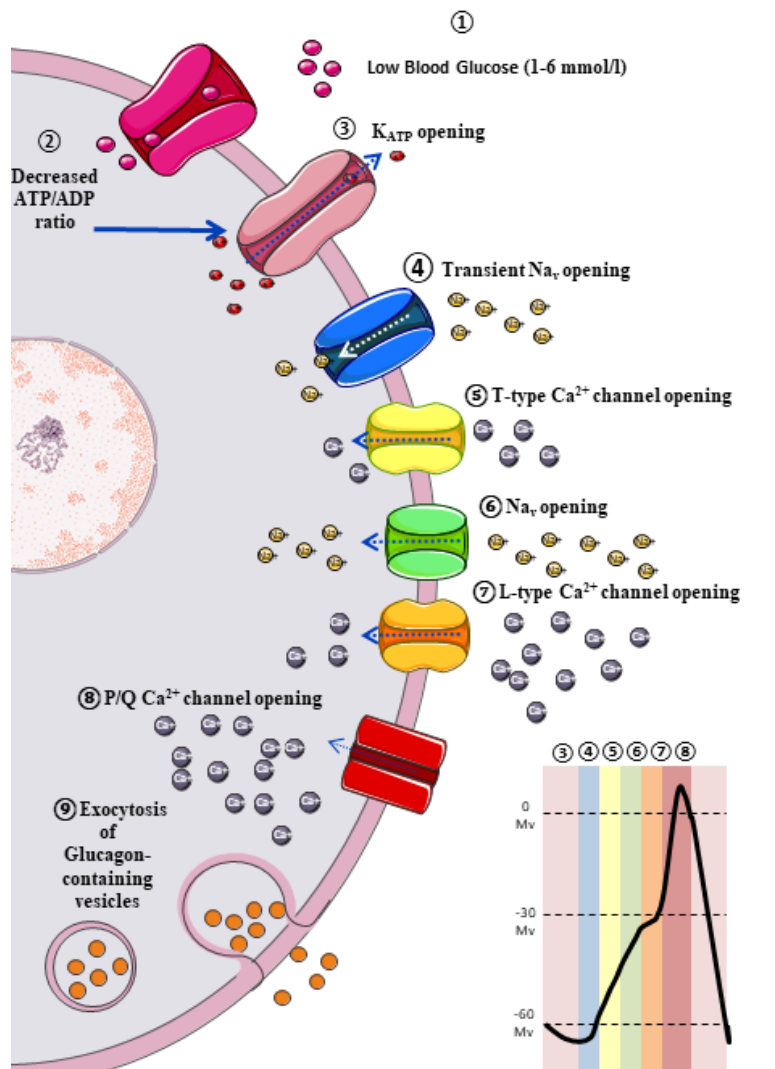
Figure 1. Intrinsic model of glucagon secretion mediated by ATP-sensitive potassium channels (K ATP ). In conditions of systemic hypoglycaemia (1–6 mmol/L) ATP/ADP ratio in α cells